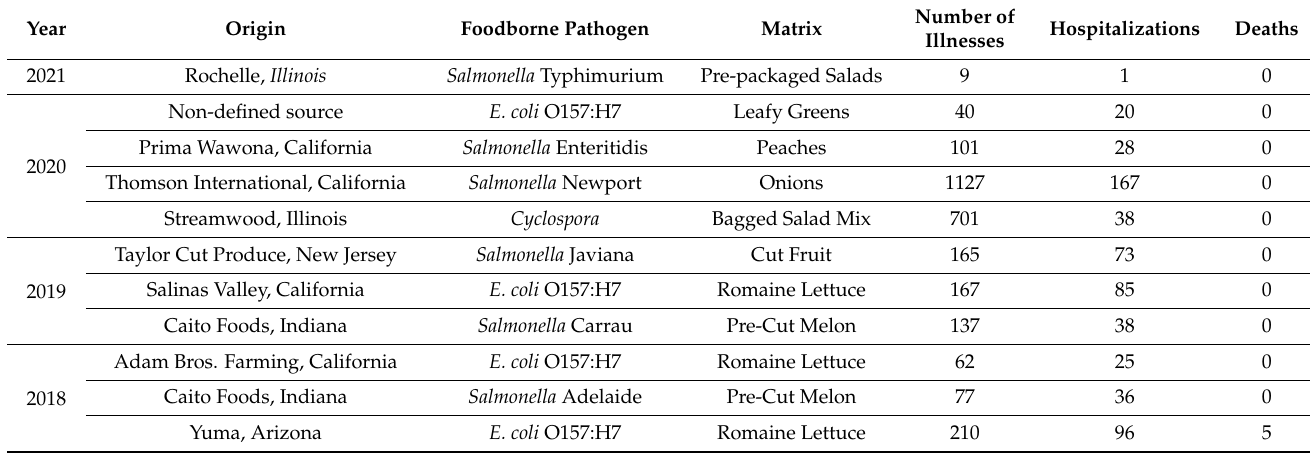
Table 1. Foodborne outbreaks linked to contaminated vegetables and fruits, occurred in the United States from 2012 to July 2021, according to Centers for Disease Control and Prevention (CDC)